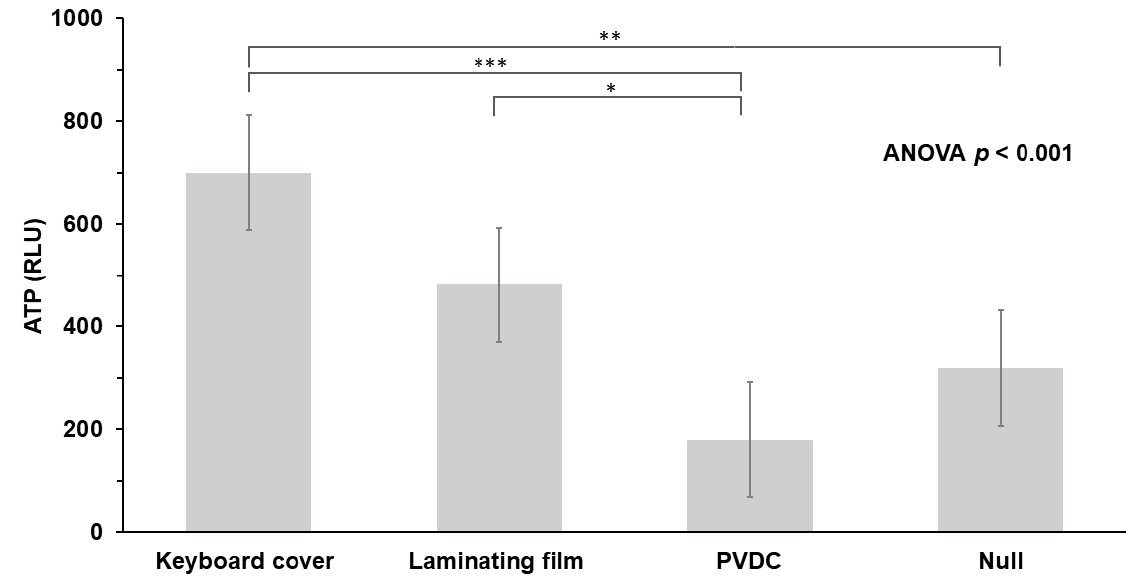
Figure 1. Values of ATP on two different plastic films, PVDC wrap and uncovered panel (null). ATP, adenosine triphosphate; RLU, relative light unit; PVDC, polyvinylidene chloride; * p < 0.05, ** p < 0.01, *** p < 0.001. Table 2. Comparison of ATP values on buttons of different locations ( n = 144).